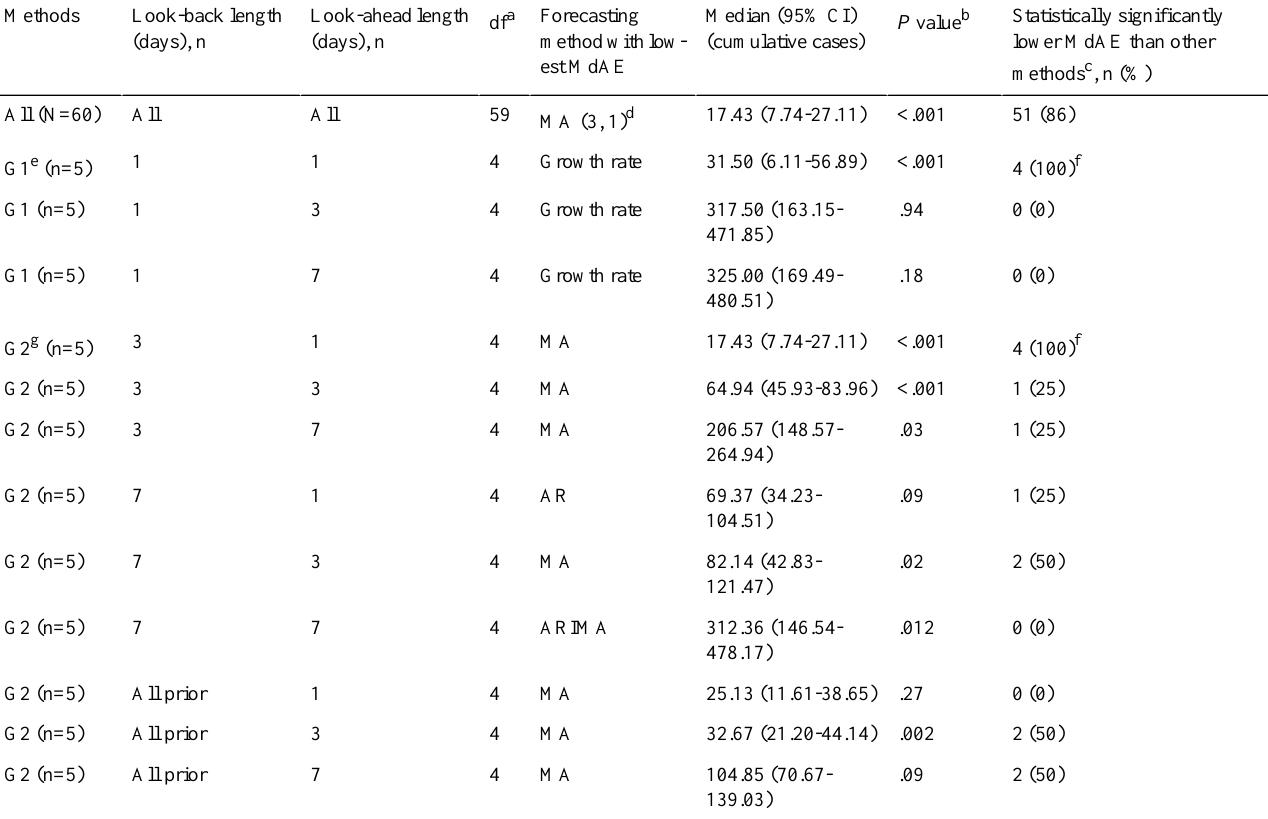
Table 3. State-level median absolute error (MdAE) outcomes by forecasting method, look-back length, and forecast